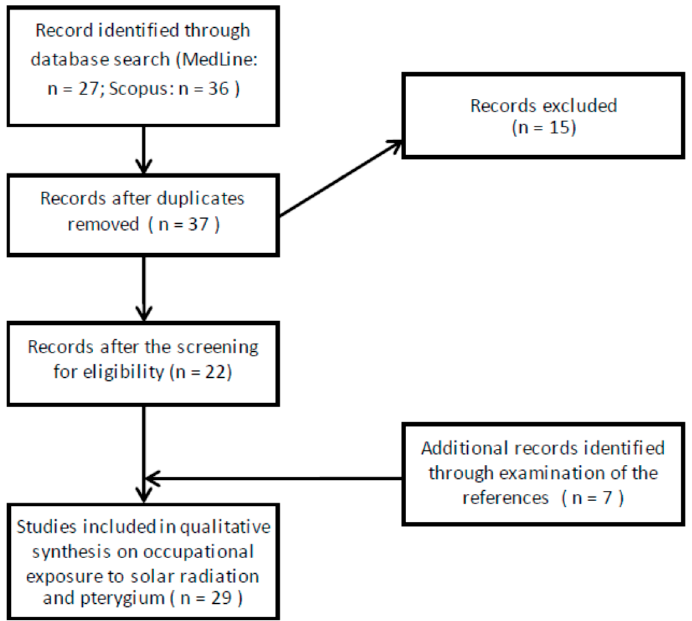
Scheme 1. Flow Diagram describing the stages of the search process of the systematic literature review on occupational exposure to solar UV radiation and pterygium.